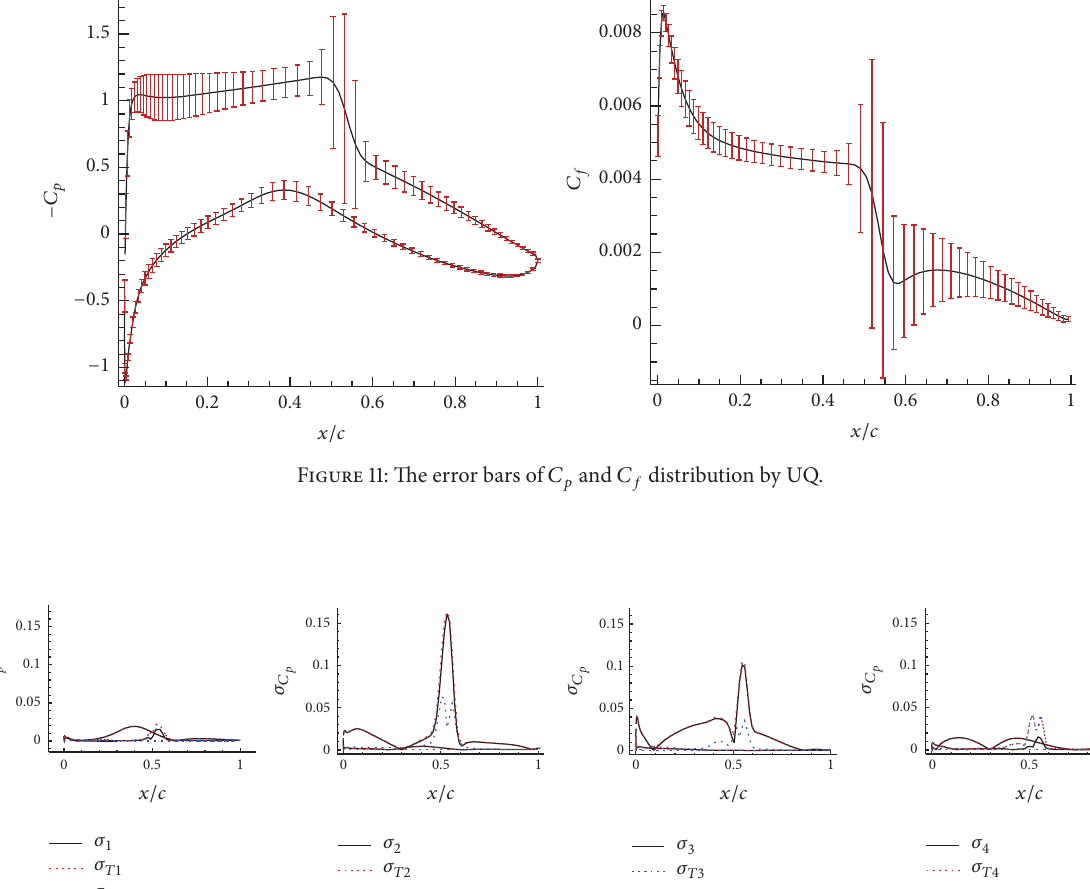
is the nonlinear coupling effect among uncertain variable 𝑖 and other uncertainty coupling 𝑖